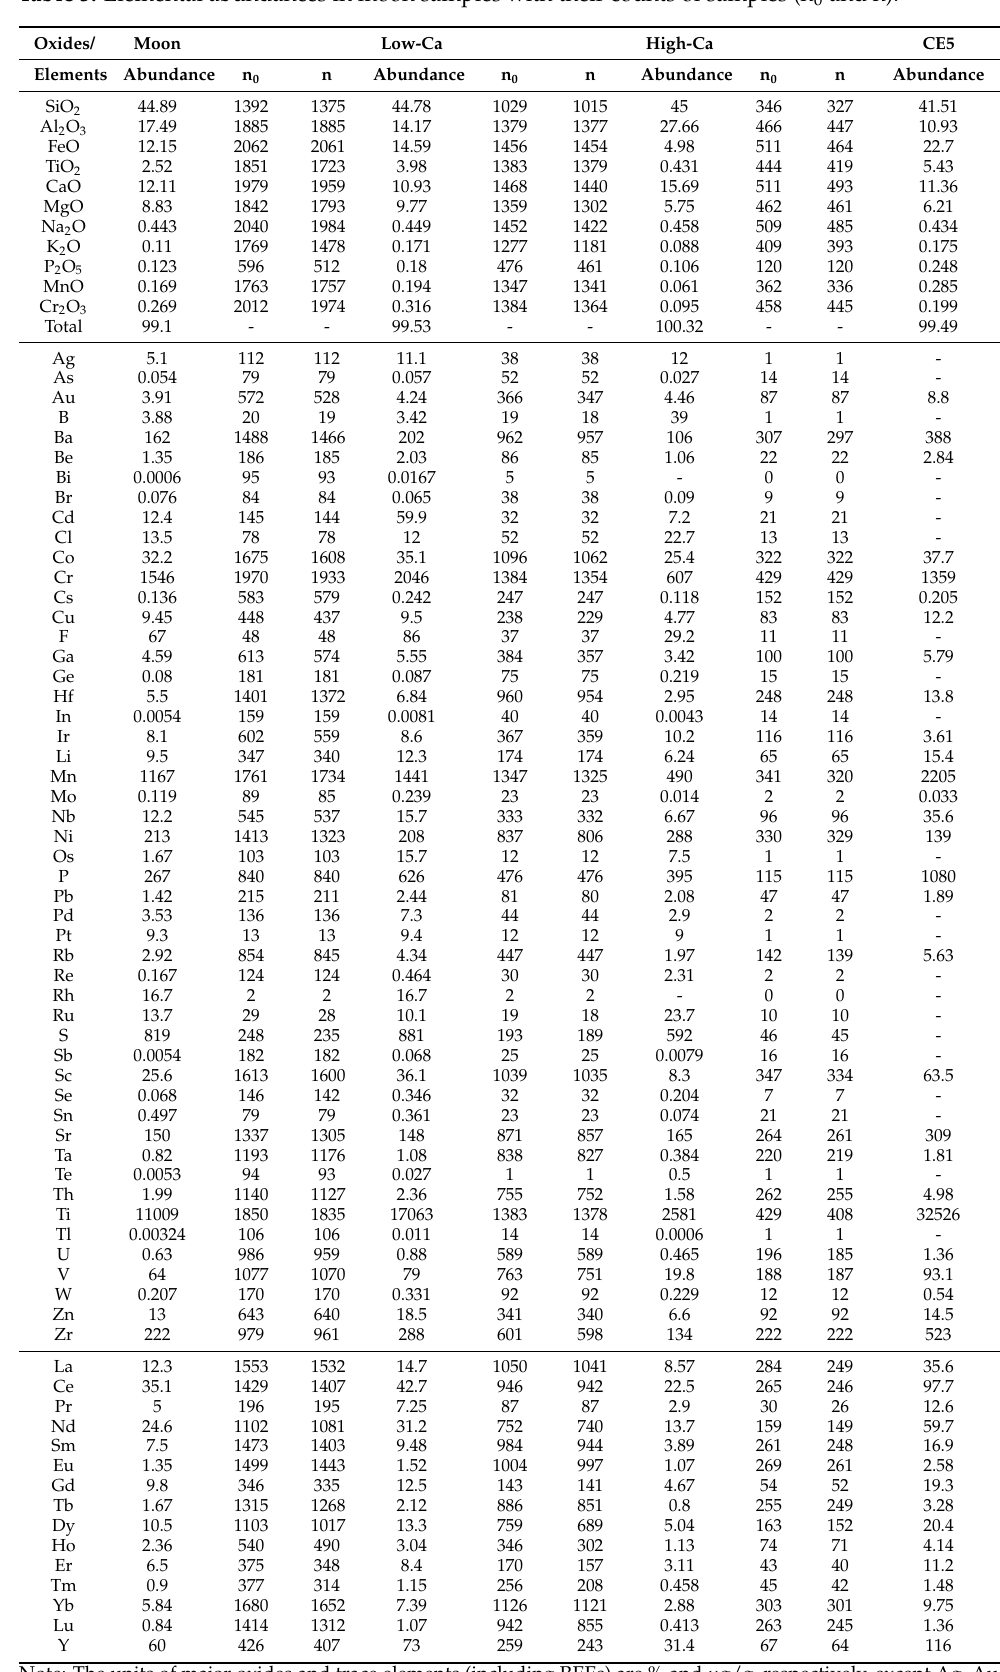
Table 3. Elemental abundances in moon samples with their counts of samples (n 0 and